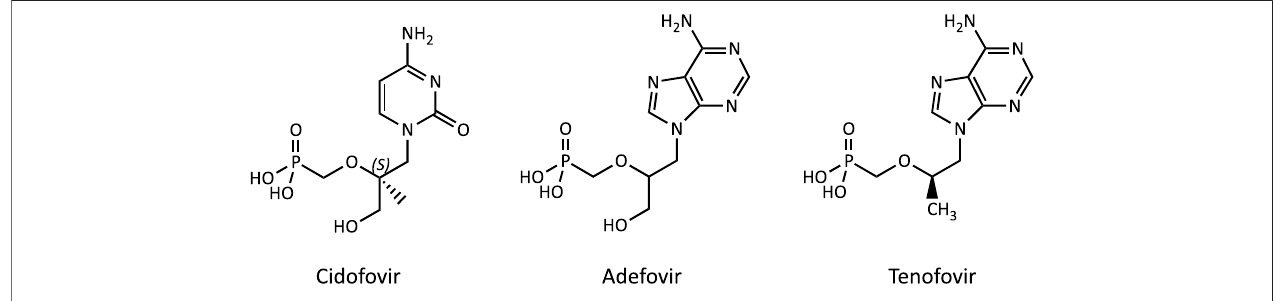
FIGURE 1 | Chemical structure of the acyclic nucleoside phosphonates (ANPs) adefovir, tenofovir and cidofovir.